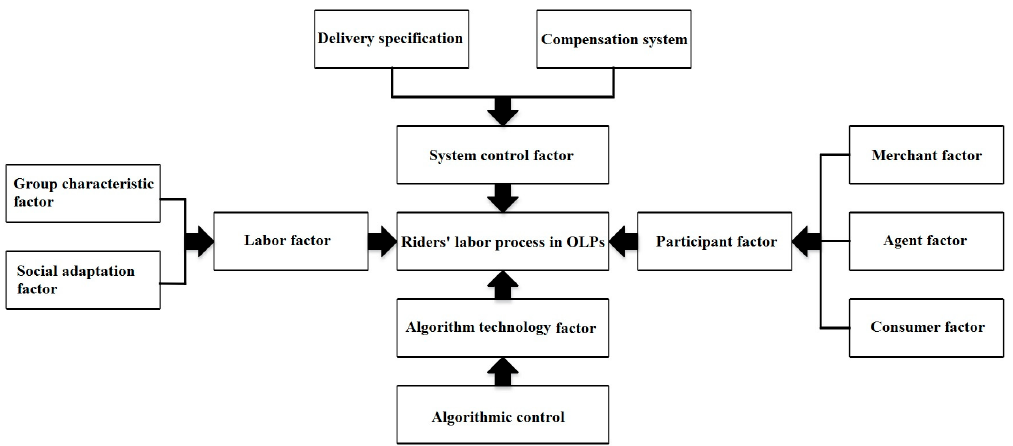
Figure 1. The influence factors of riders’ labor process and mental health.